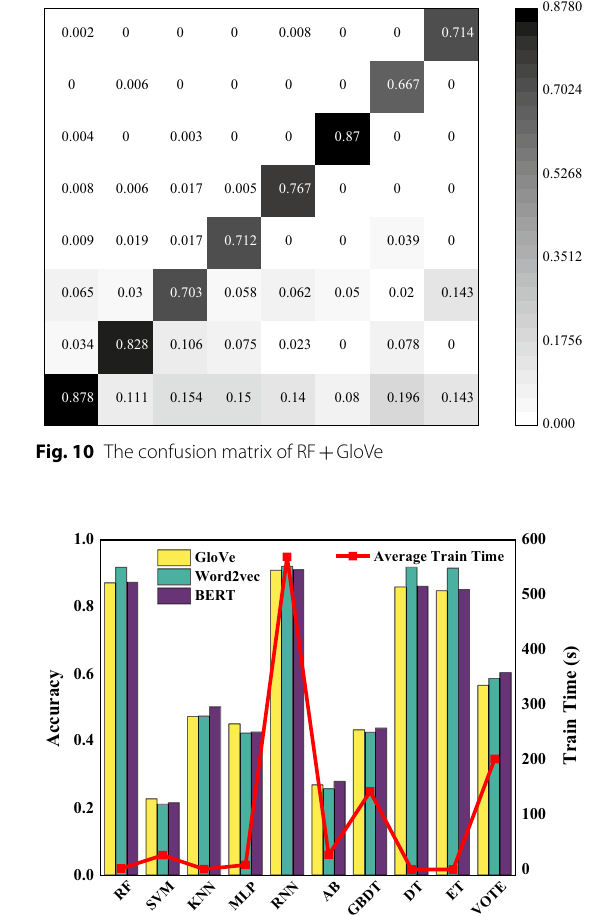
Fig. 11 The accuracy and average training time result with data augmentation